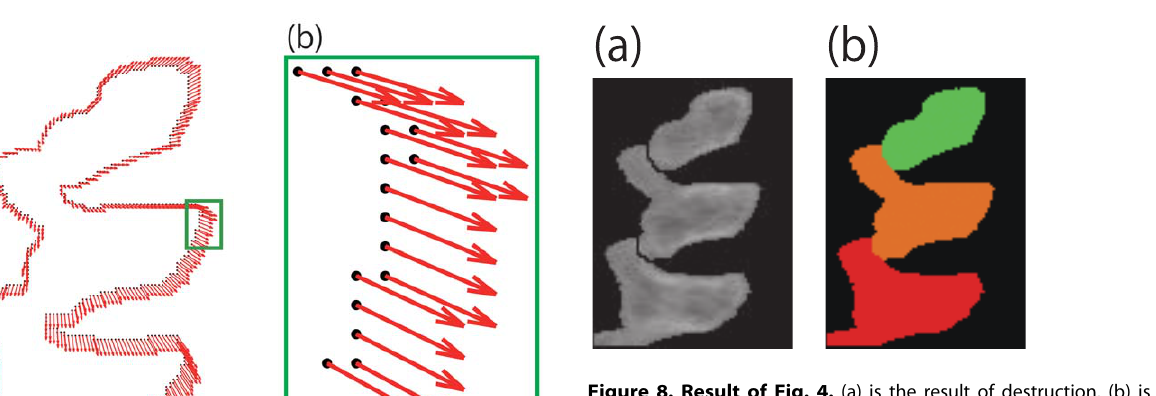
Figure 8. Result of Fig. 4. (a) is the result of destruction. (b) is the repaired version of (a).